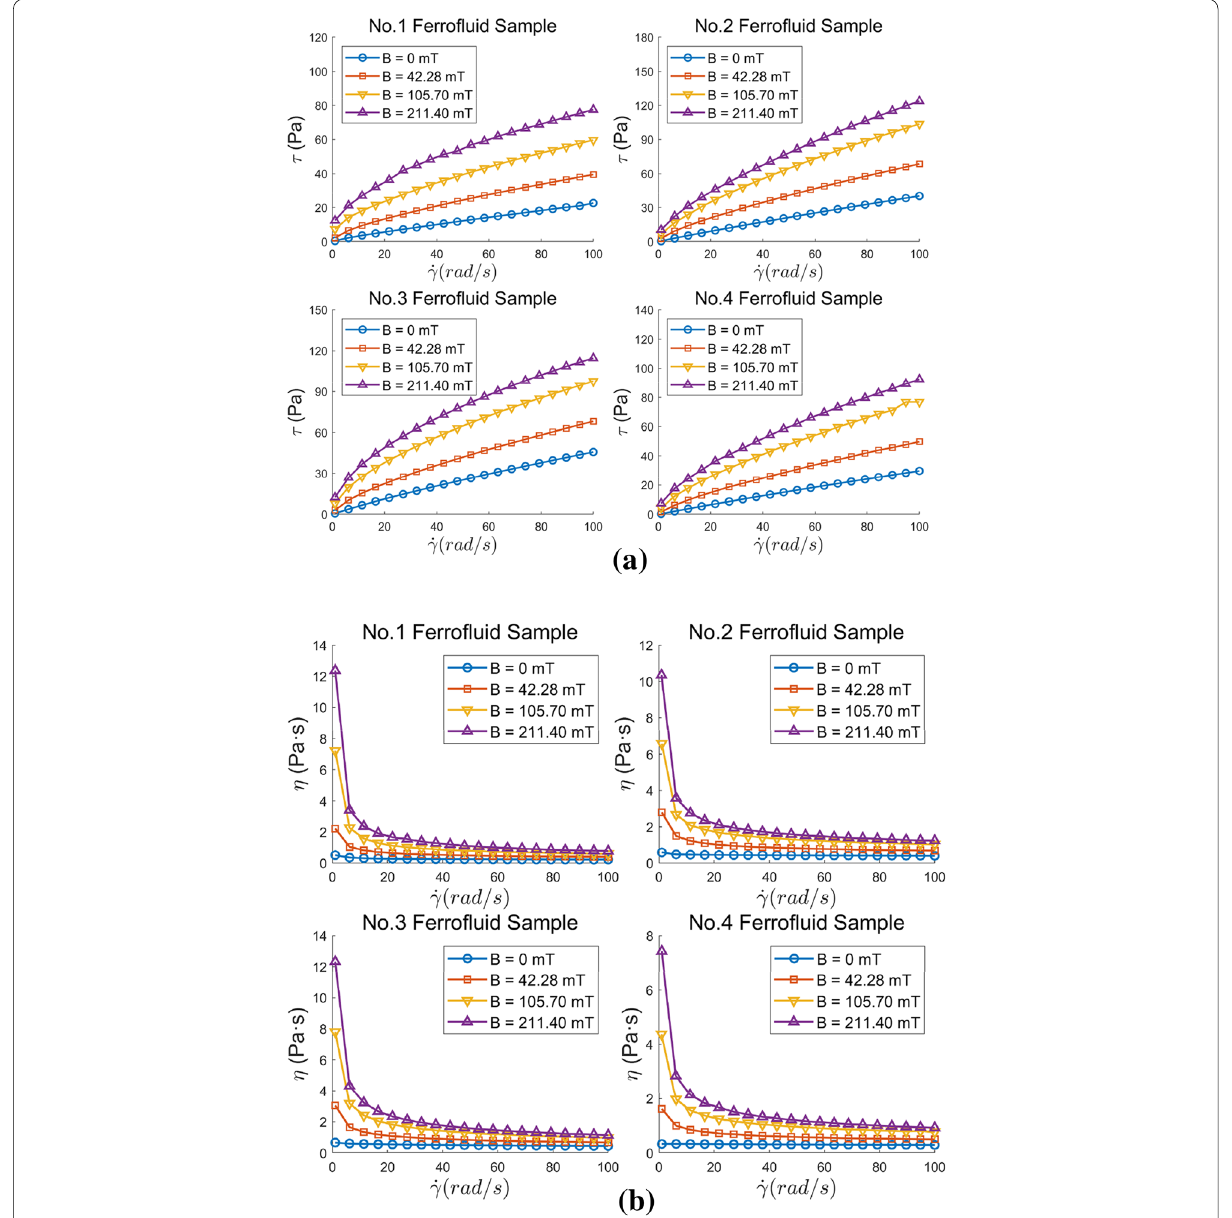
Figure 4 Dependence of shear stress ( a ) and viscosity ( b ) on shear rate of ferrofluid samples under different external magnetic